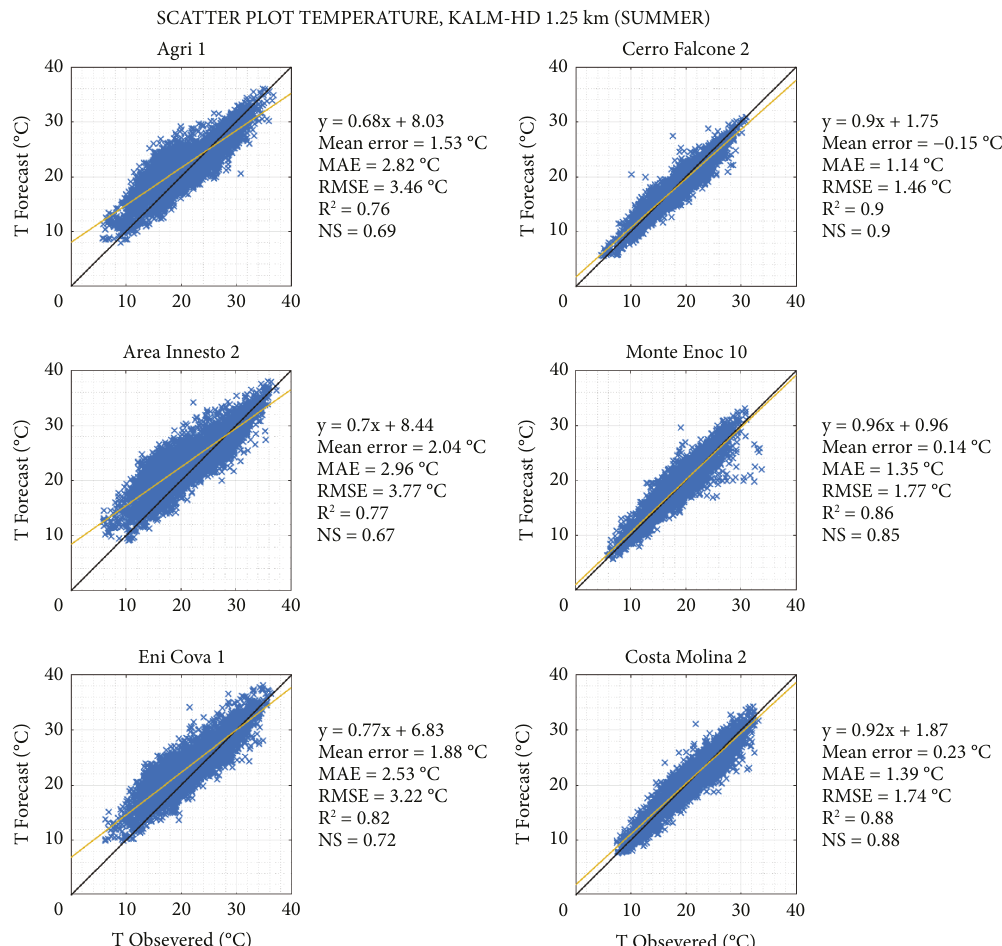
Figure 9: Scatter plots of the KALM-HD model with 1.25km as grid resolution vs. observed data for the hourly temperature forecast in summer (JJA), over the six stations at day +1 as lead time for the whole two years of the observation period. On the left are the “valley stations,” and on the right are the “mountain